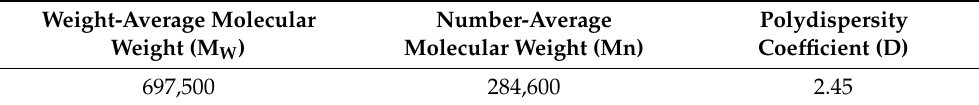
Table 3. Relative molecular weight test results of PAASM.